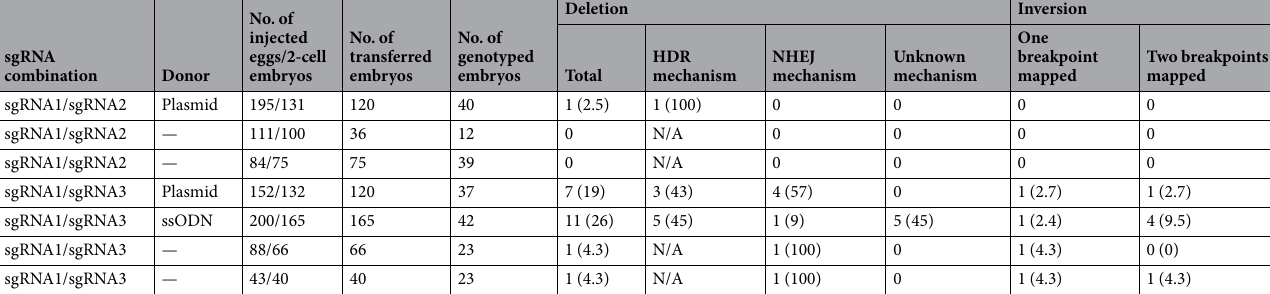
mutants (Fig. 2B, Table 1). Sequencing analysis of the PCR products showed that three carried the same sequence as that of the donor sequence, including the junction of arm3 and arm1 (#13, #25, #26 in Fig. 2C, Supplementary Figure 2), whereas the remaining four contained sequences of arm3 and arm1; however, sequences of the junc- tion were different from that of the donor plasmid (#2, #3, #32, #24 in Fig. 2C, Supplementary Figure 2), indi- cating that the former three were generated by HDR and the latter by NHEJ. To determine whether the deletions occurred homozygously in all cells, we PCR-amplified genomic regions around sgRNA targets using primer pairs 1F3/1R1 and 3F1/3R2. The PCR products were obtained from both regions in all samples (Supplementary Figure 4A,C), suggesting that not all cells contained the homozygous deletion in all samples. Large deletions can be created by the CRISPR/Cas9 system without a donor plasmid.